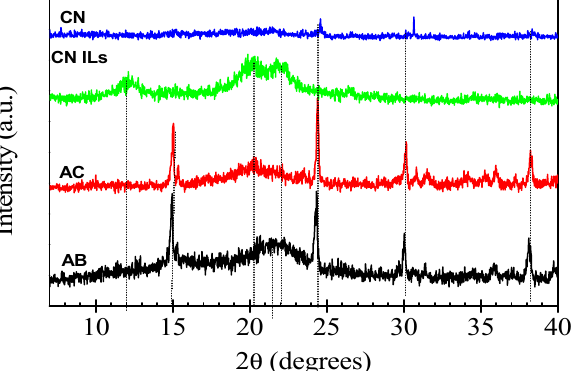
Figure 3. XRD diffractograms of agave bagasse (AB), agave cellulose (AC), cellulose nanofibers with ionic liquids (CN ILs), and cellulose nanofibers (CN).